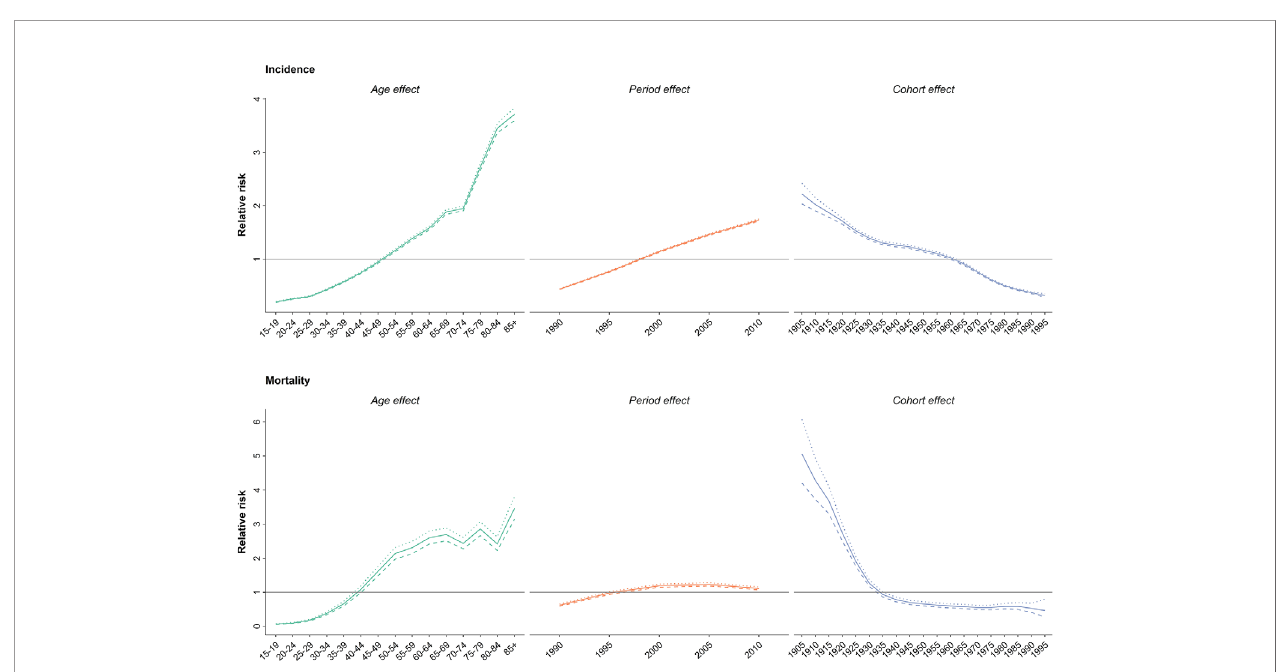
FIGURE 2 | Effect of age, period and cohort on relative risk of incidence (above) and mortality (below); dotted line: upper limit, dashed line: lower limit .